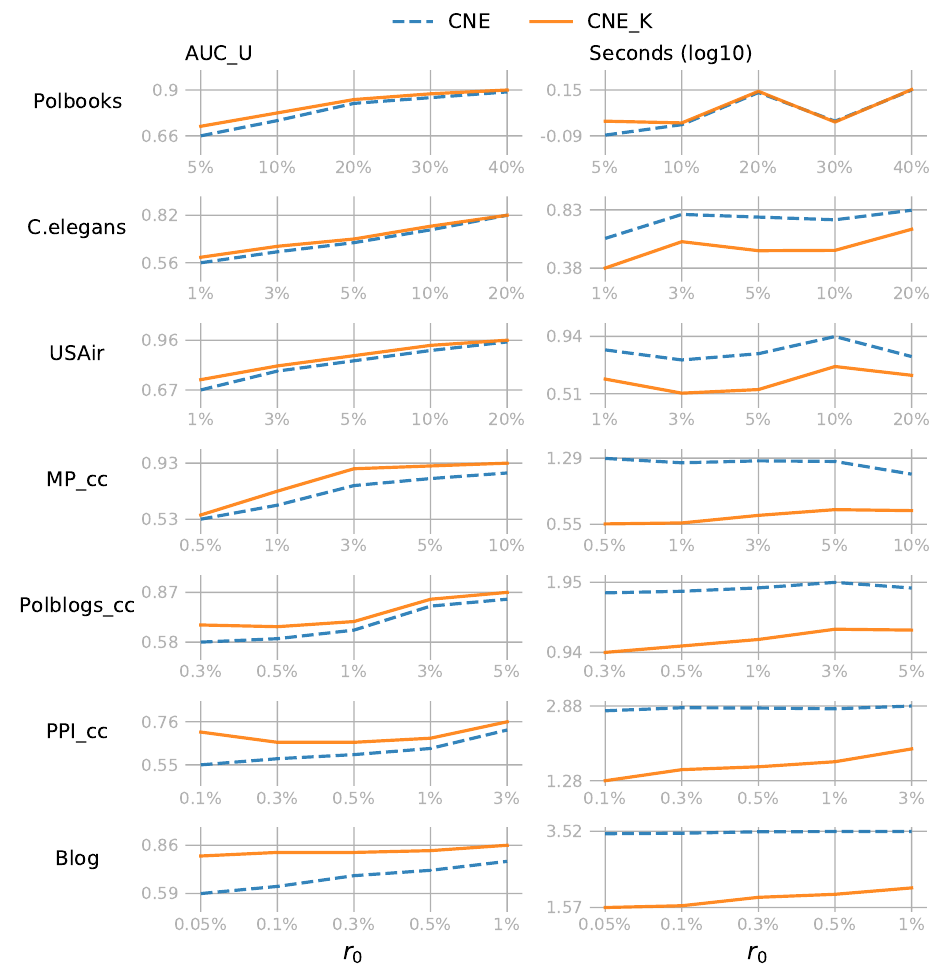
Figure 2. Comparison of CNE_K and